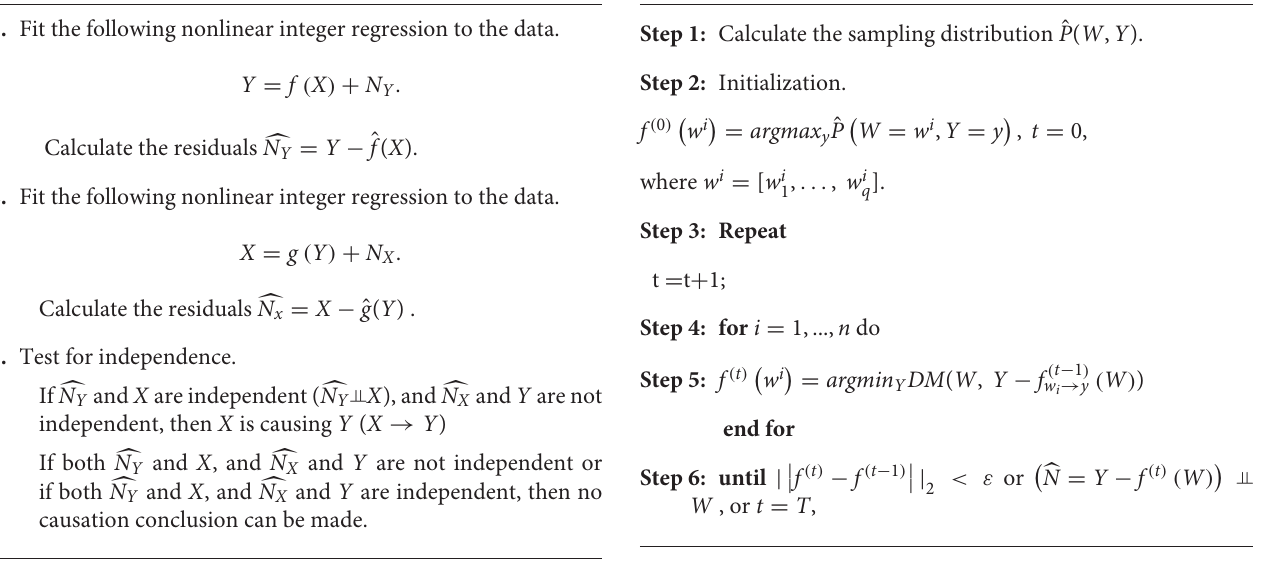
Algorithm 1 for Causal Genetic Analysis Using ANM: Algorithm 2 (Distance Regression With Dependence Measure)